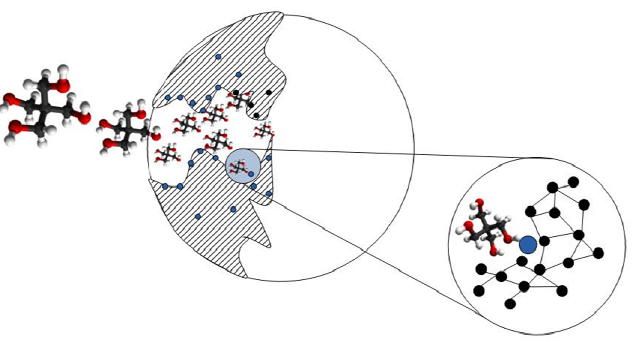
Figure 6. Scheme of filling pyrolyzate with pentaerythritol molecules composed of carbon (black), oxygen (red) and hydrogen (white) atoms. The molecules penetrate into the pores of the matrix of carbon (black) and interact with released Eu atoms (blue) at pores border by diamond synthesis. In carbon matrix material the Eu inclusions (blue dots) are shown